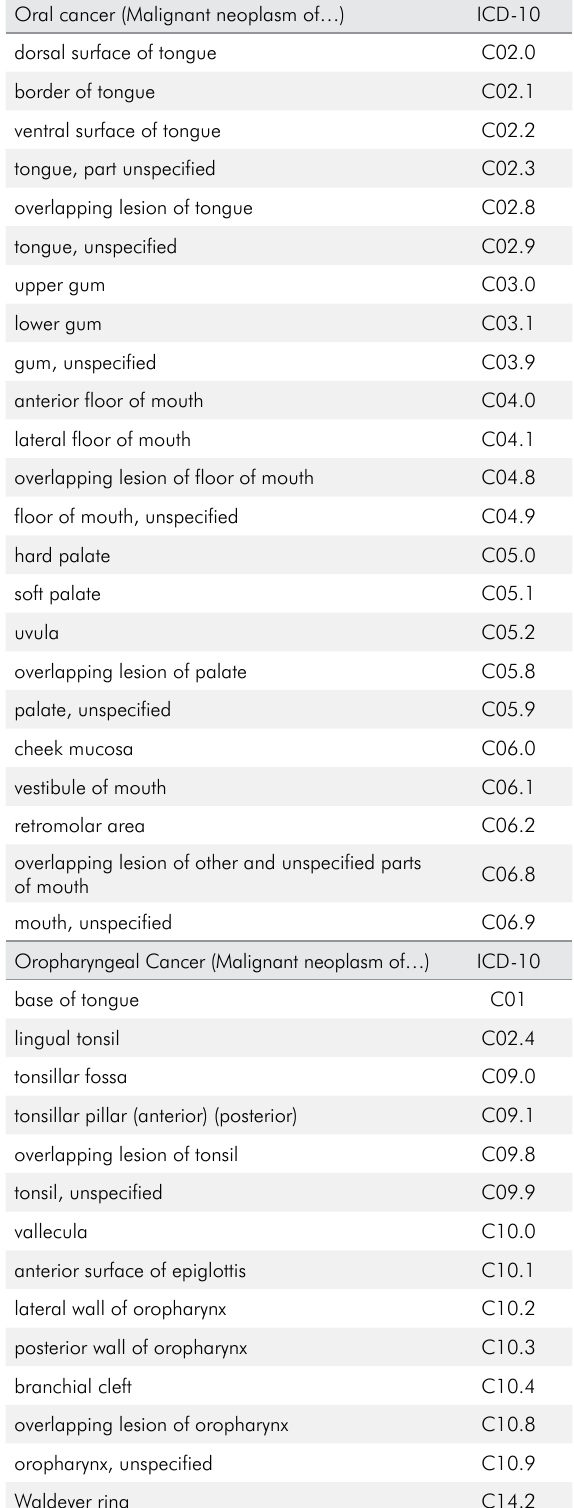
Table 1. International Classification of Diseases, tenth revision (ICD-10) codes included in the categories of “oral cancer” and “oropharyngeal